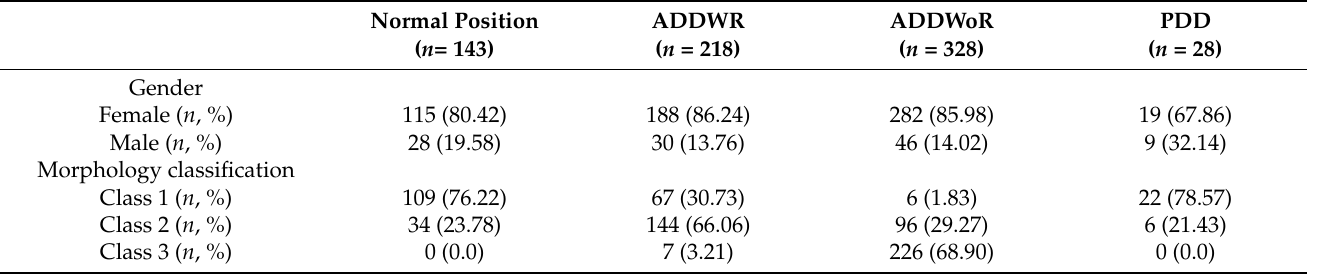
Table 1. Details of the study population.